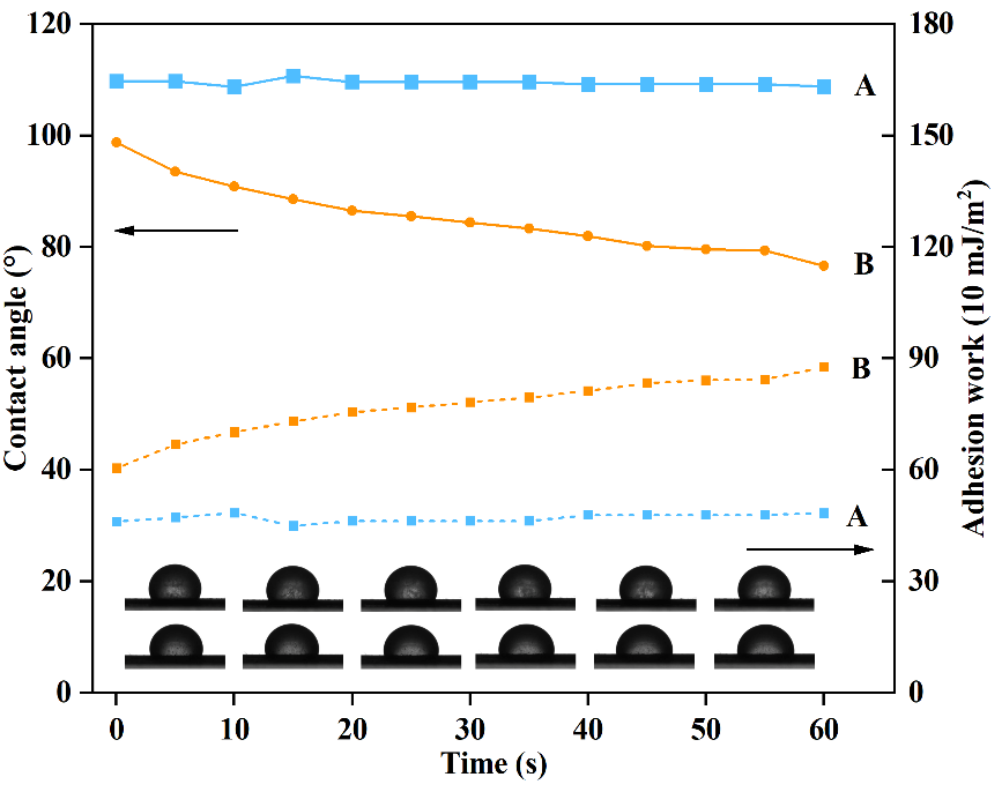
Figure 8. Contact angles and adhesion works of PRO@DMON nanoparticles and PRO@DMON–GA–Fe(III) nanoparticles on rice blades.